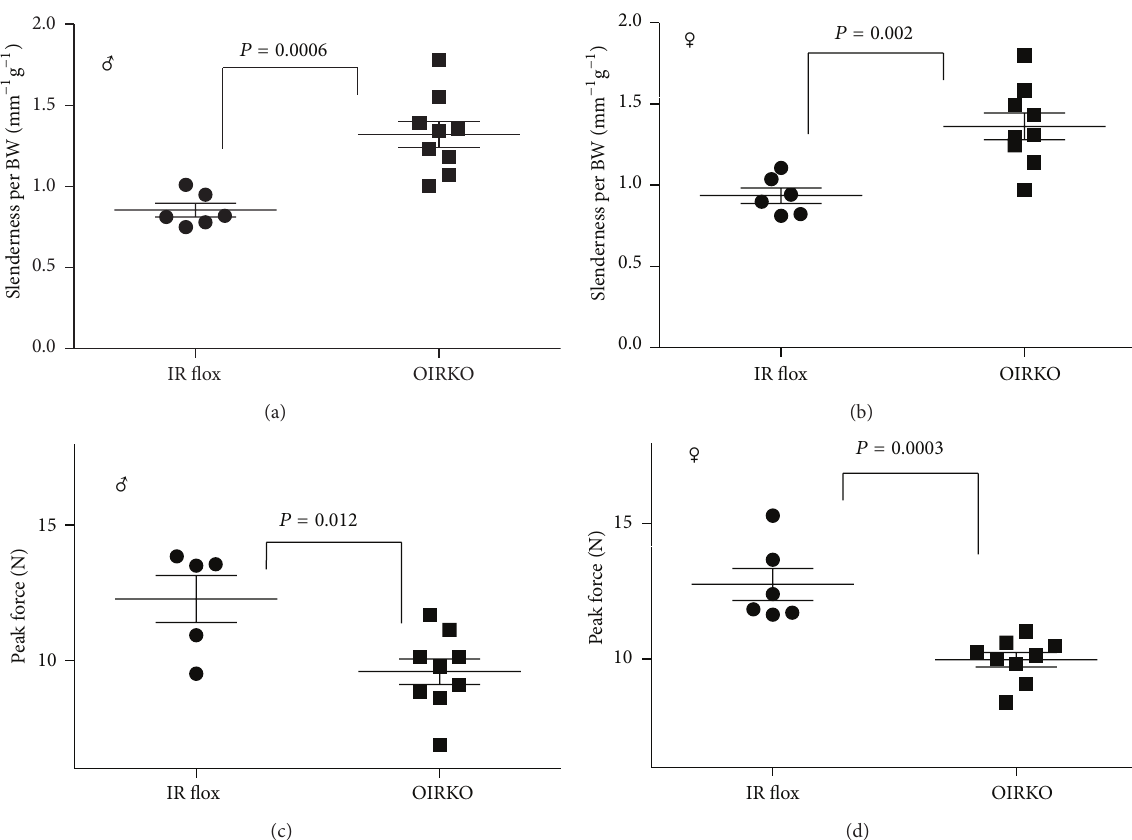
Figure 2: OIRKO femurs are weaker and more slender. Loss of IR in osteoblasts caused the bone to be more slender (ratio of length to total cross-sectional area) relative to body weight (Length/Tt.AR per BW; (a), male; (b), female). Loss of IR in osteoblasts also caused a decrease in the structural strength of the femur in bending (peak force; (c), male; (d), female). Data is displayed as a scatter-plot, with mean and SEM